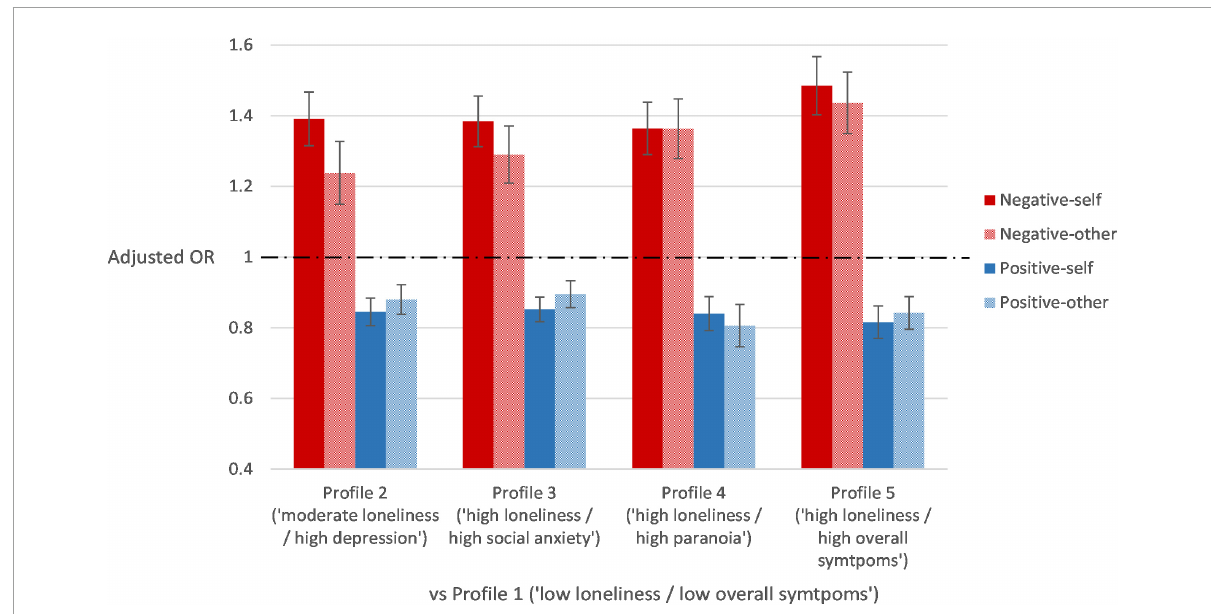
FIGURE2 Adjusted odds ratios and the 95% confidence intervals of the prediction of profiles by core schemas after adjusting for demographic